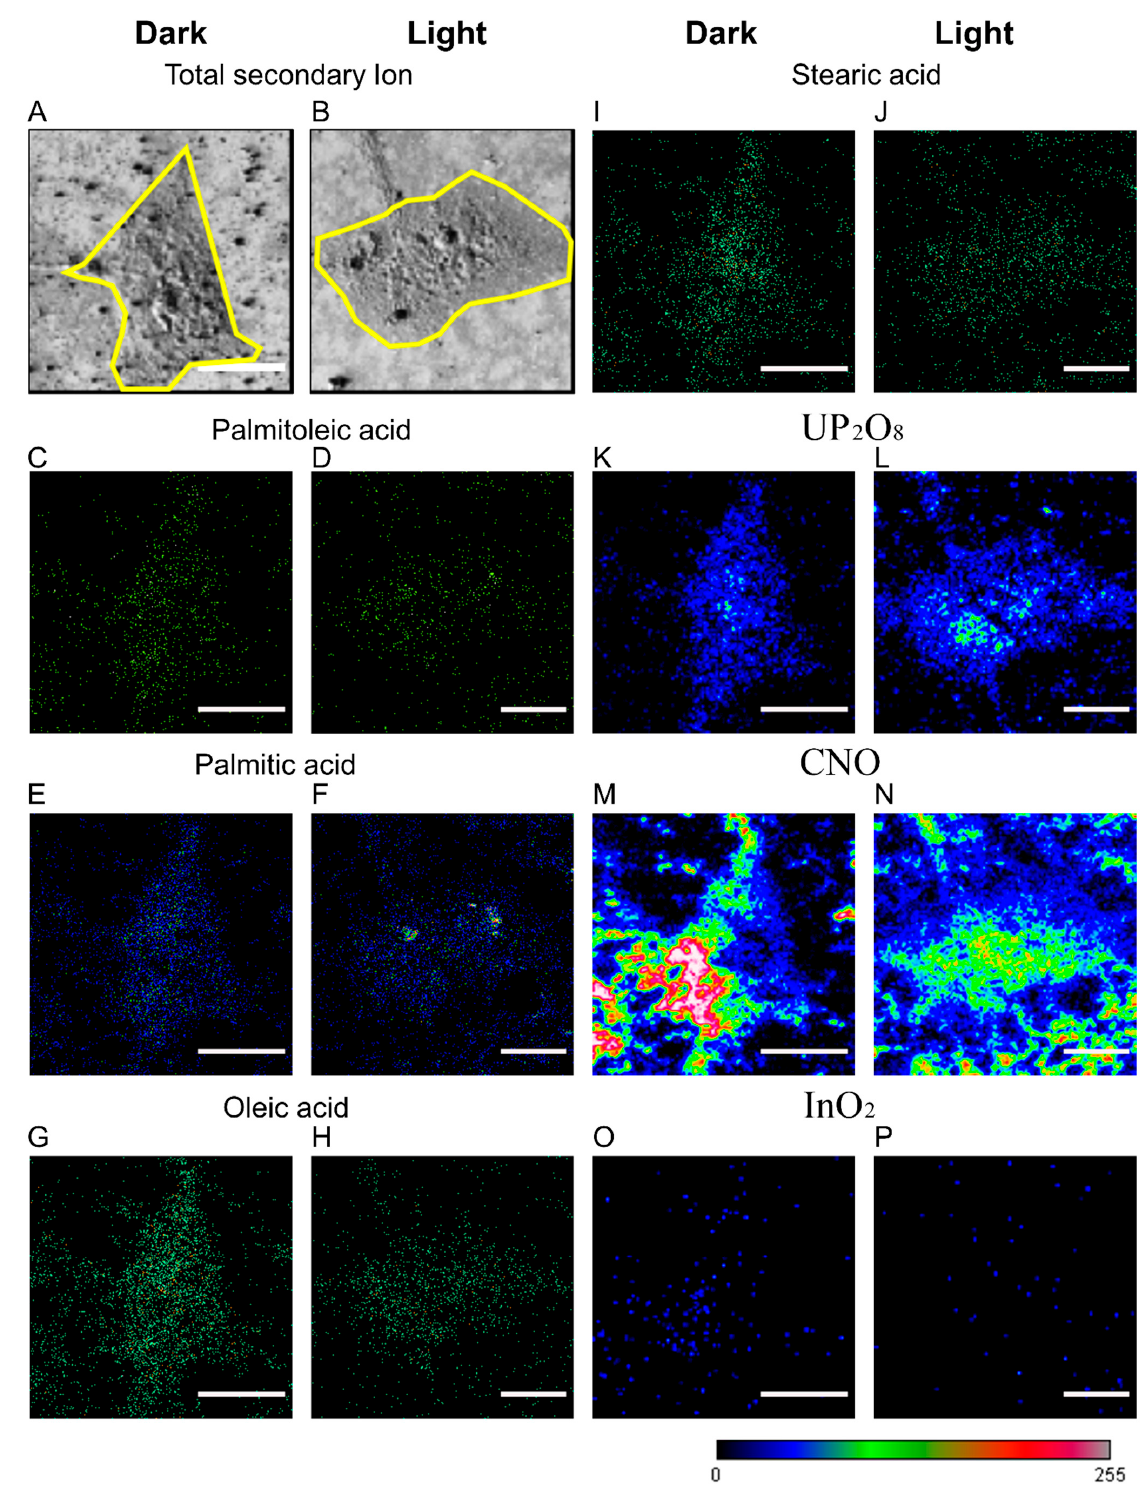
Figure 4. TOF-SIMS images of PM FAs. COS-7 cells were introduced with optoKiC under 1 h dark and light conditions and then imaged by TOF-SIMS. ( A , B ) The total secondary ion images of the cells under dark and light conditions (Yellow frames: Cell outlines). ( C – J ) The ion images of POA, PA, OA, and SA under dark and light conditions. ( K – P ) The ion images of UP 2 O 8 (signal from uranium salt for fatty acid fixation), CNO (signal from biomolecules, such as protein), and InO 2 (signal from ITO glass and background noise) under dark and light conditions. Scale bars: 25 µ